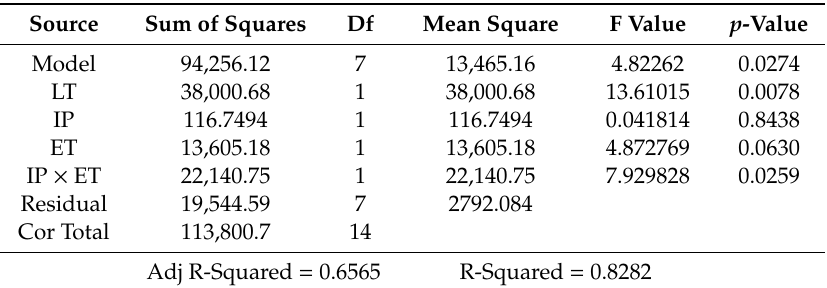
Table 6. Analysis of variance